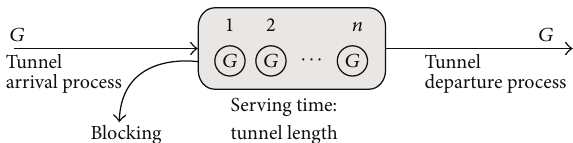
Figure 10: Simple toy model for tunnel-induced load on the core